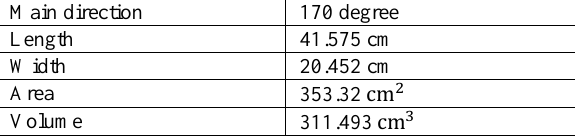
Figure 24. Drawing a region of interest